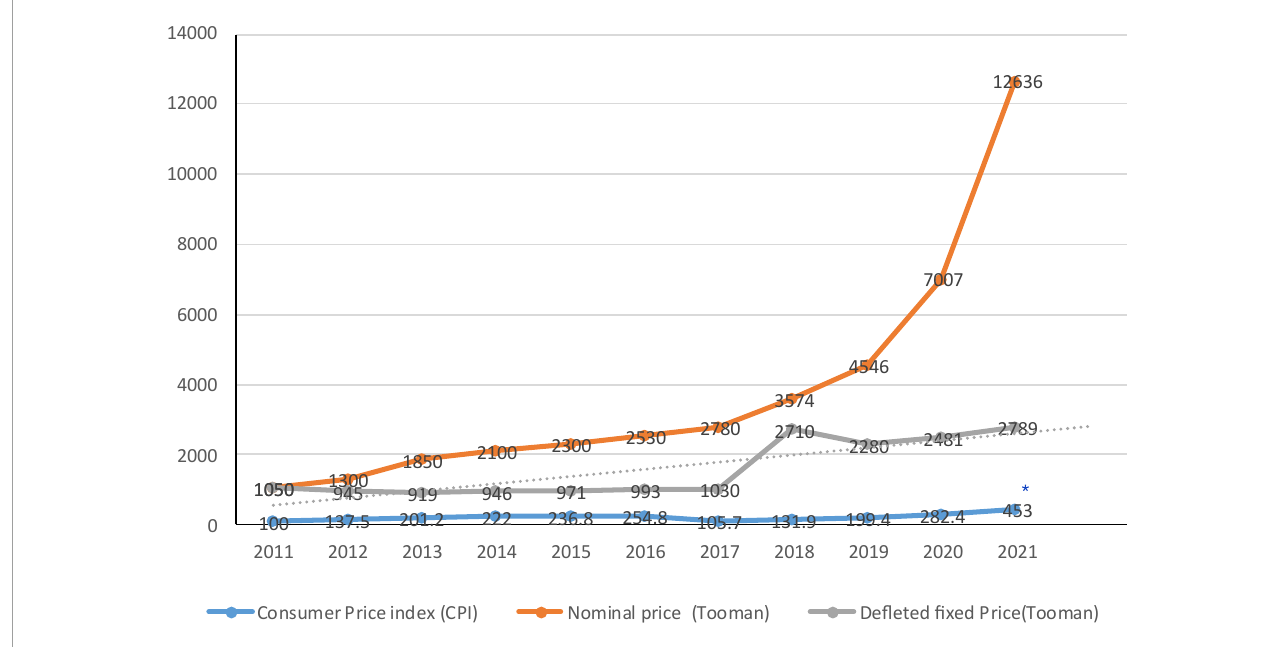
FIGURE4 The consumer price index, nominal price, and deflated fixed price of 1.5-liter carbonated soft drinks (Tooman) in Iran during 2011 – 2021. ∗ The consumer price index from 2011 to 2016 was obtained from the Central Bank of Iran based on 2011 as a basic year and those of 2017–2021 adapted from SCI based on 2016 as the basic